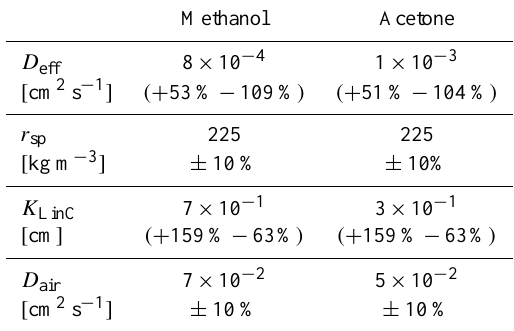
Table 1. Calculated effective diffusion constant ( D eff ) of methanol and acetone for snow-maker snow at 243K. Calculation were done based on Eq. (1) with the solid ice/air ratio ( r sp ), the gas-phase diffusion constant ( D air ) and the Langmuir partitioning coefficient ( K LinC ) as input.